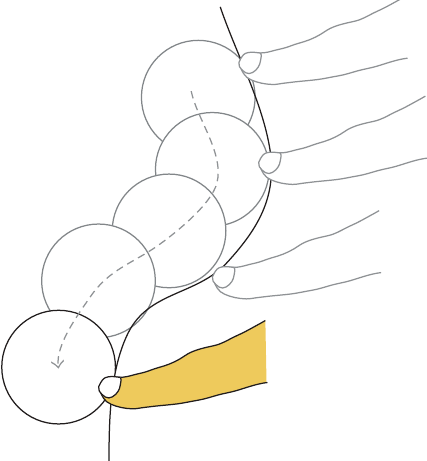
Figure 2: Principle for presenting smooth two-dimensional shapes in the MPTD presentation. The touched object is moved on the two orthogonal axes according to the finger